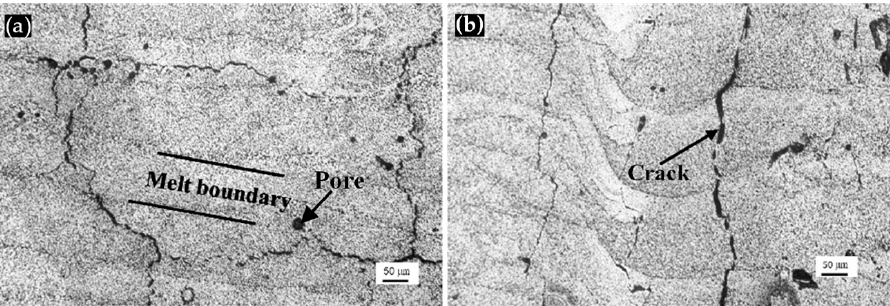
Figure 3. Microstructure of the LPBF-fabricated AA6061: ( a ) XY plane (perpendicular to build direction); ( b ) ZX plane (build direction). Reproduced with permission from Elsevier [38].